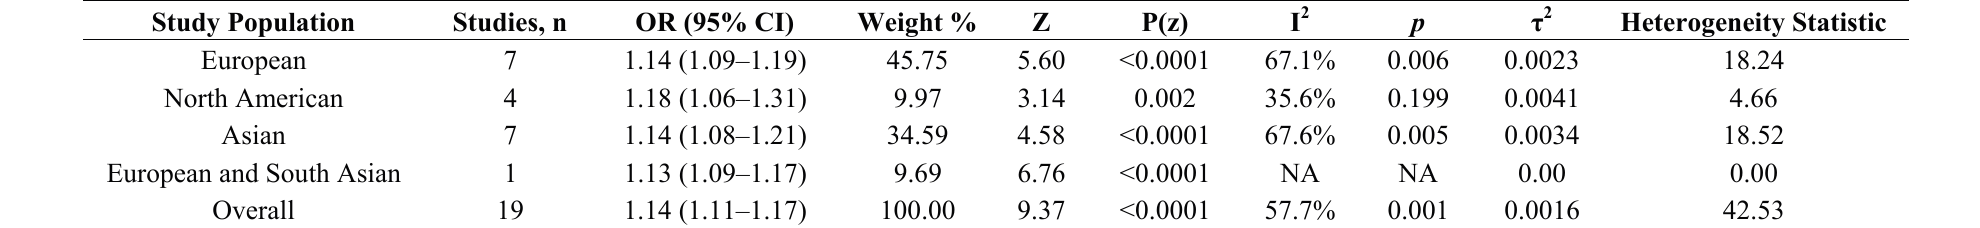
Table 5. Summary estimates of the OR of rs12526453 polymorphism in subgroup